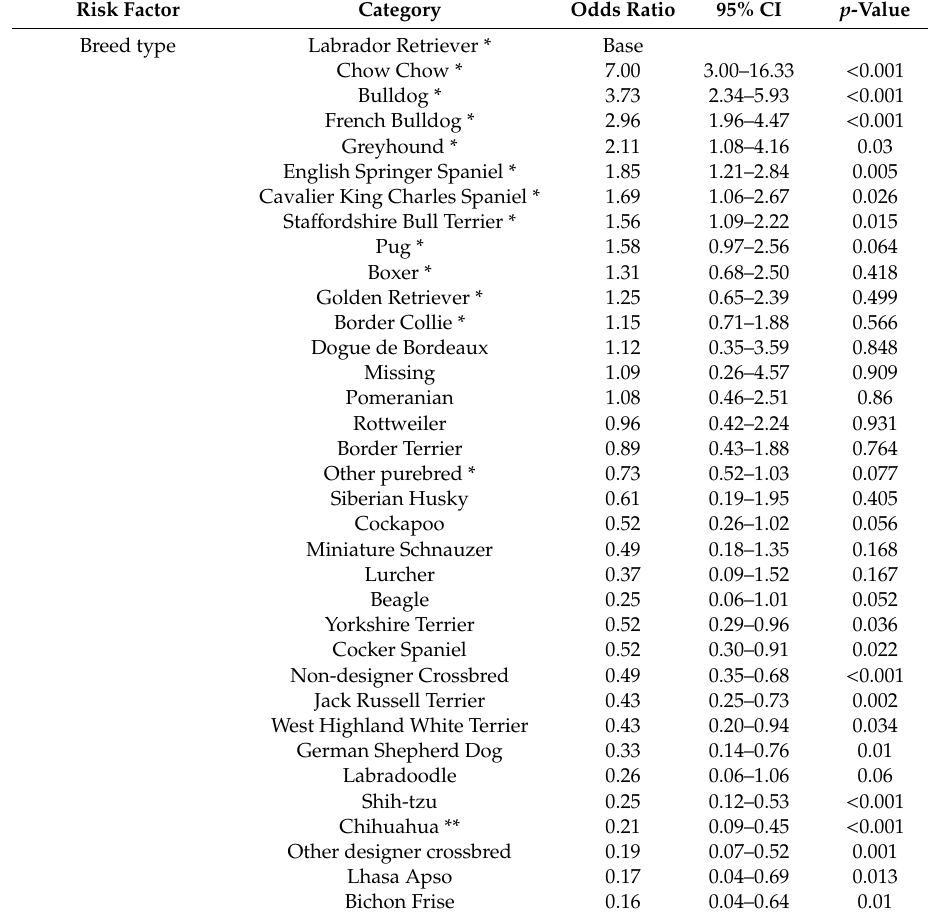
Table 3. Multivariable binary logistic regression results for risk factors associated with exertional heat-related illness in dogs under primary veterinary care in the VetCompass